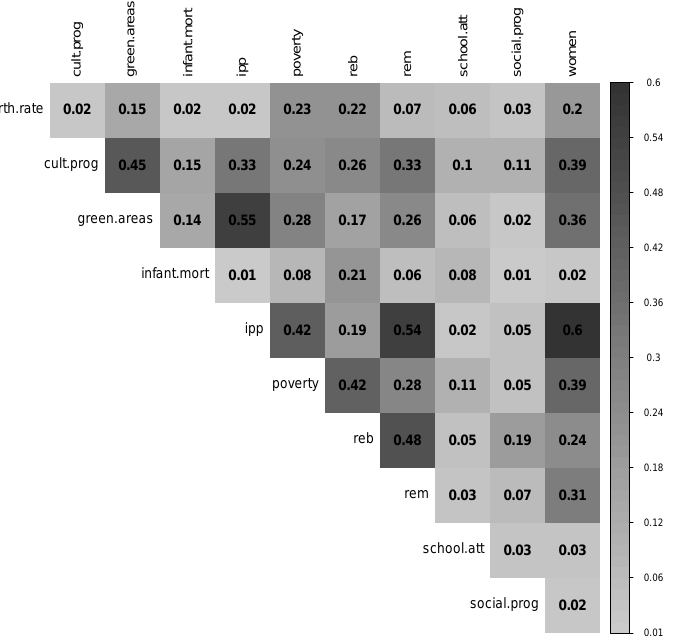
Figure 3. Correlation matrix associated with the variables related to the